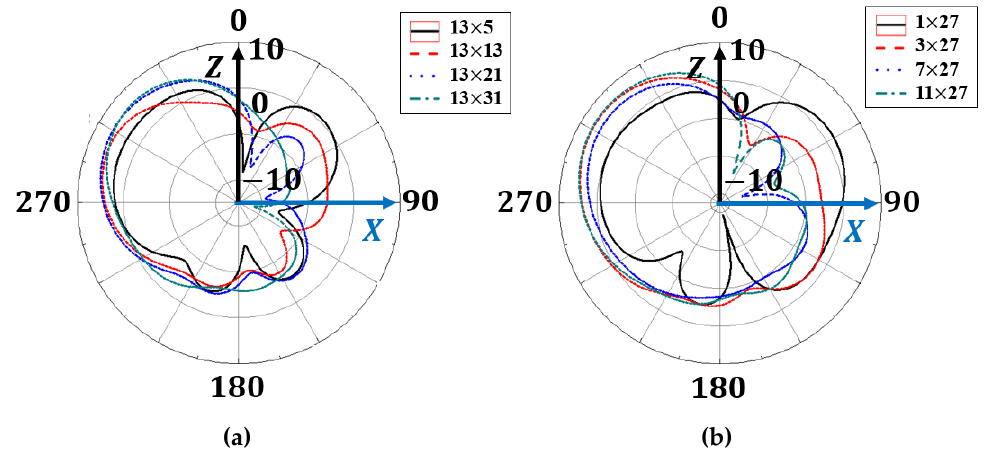
Figure 7. Simulated radiation patterns for different metamaterial absorber (MMA) array ( a ) rows and ( b ) columns.